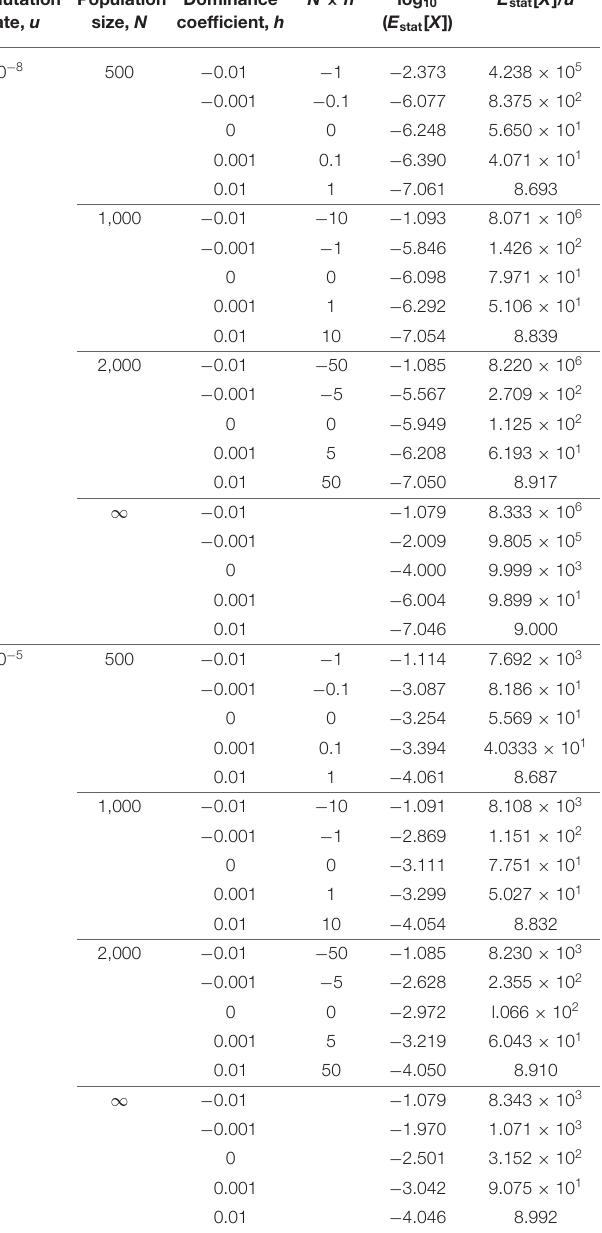
TABLE 1 | Finite and infinite population frequencies when at stationarity/equilibrium. Mutation Population rate, u size, N